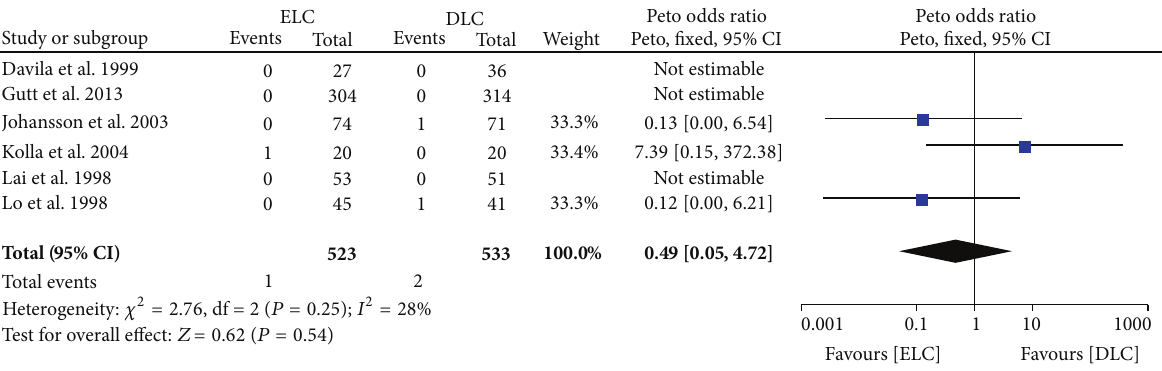
Figure 1: Meta-analysis of bile duct injury in ELC versus DLC. Peto odds ratio shown with 95% confidence intervals.